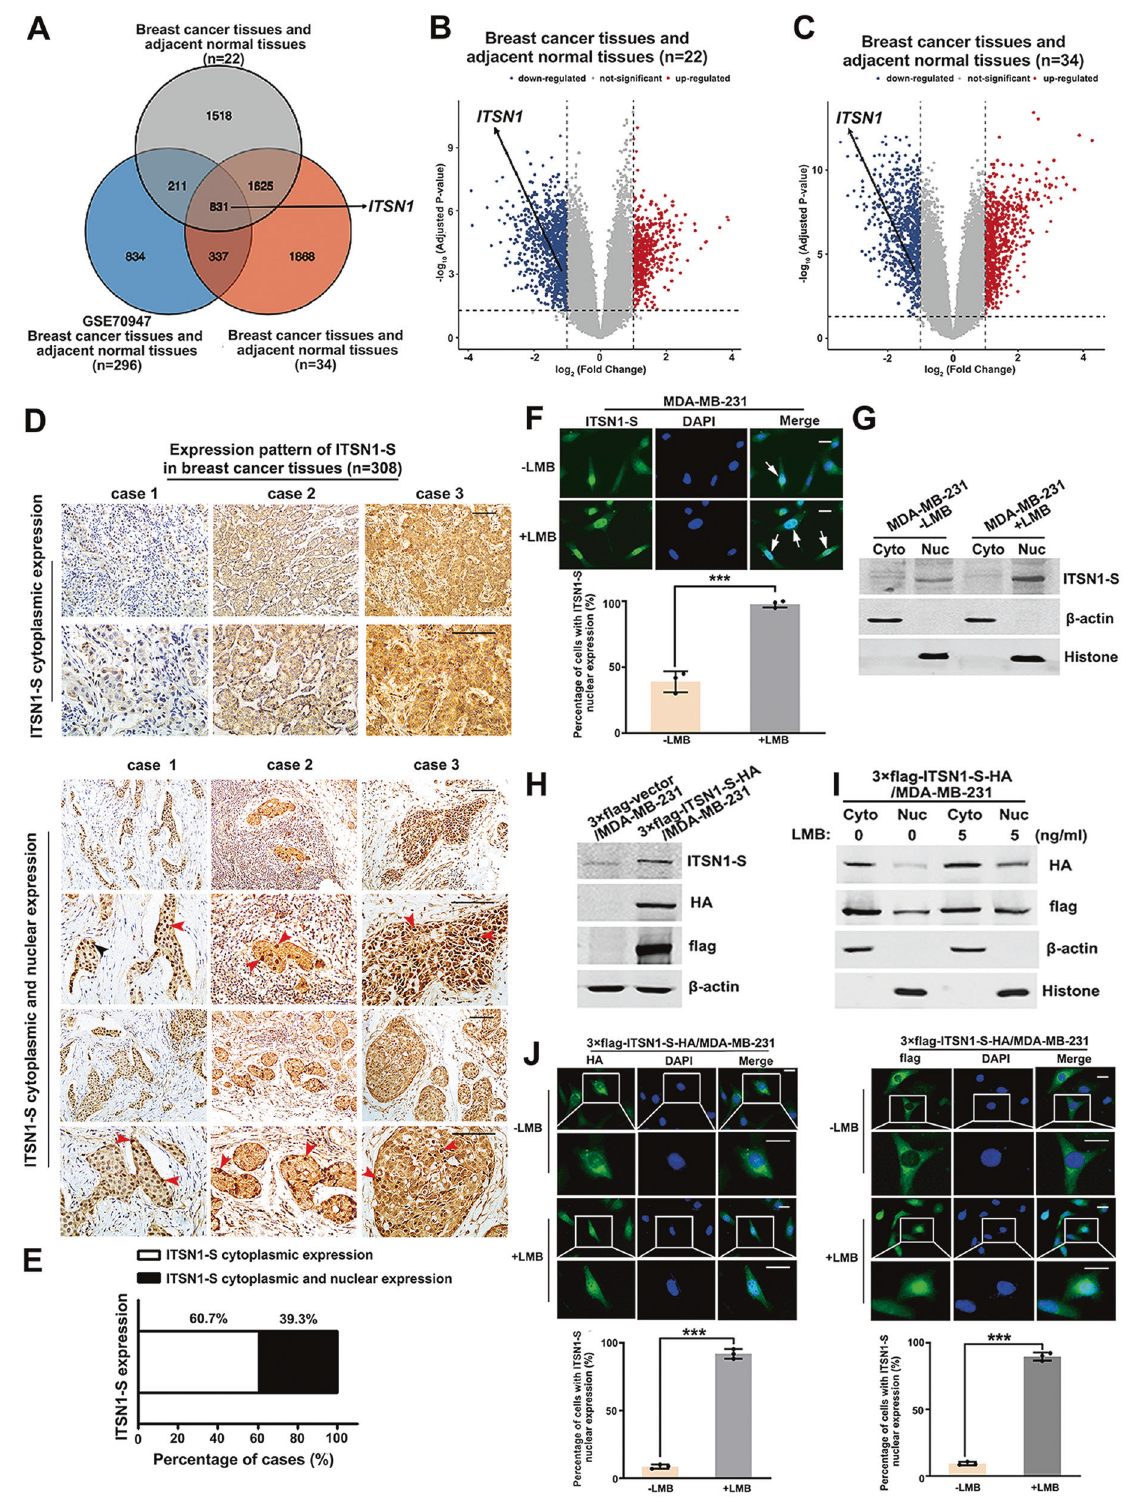
with adjacent normal tissues (Fig. 1B, C). It suggested an important role of ITSN1 in the suppression of breast cancer progression. Then we performed immunohistochemistry (IHC) to examine the localization of ITSN1-S, the major isoform of ITSN1 in breast cancer in breast cancer tissues [12]. IHC analysis showed